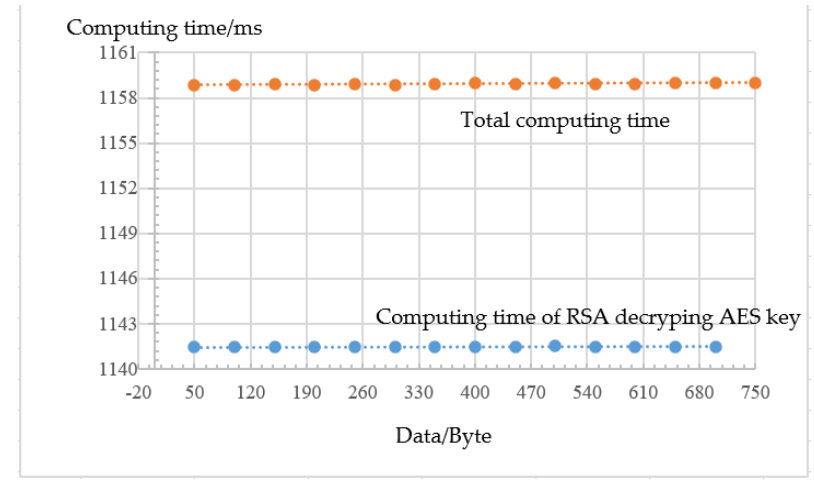
Figure 11. Scheme computing time test result.